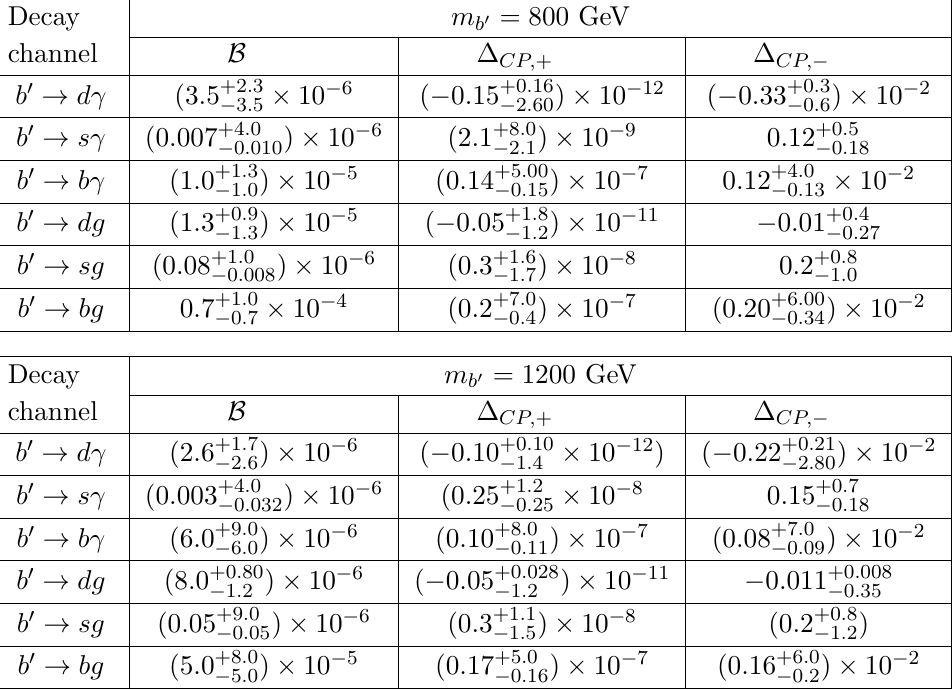
Table 4 . Results for the branching ratios and CP asymmetries for the radiative decay channels of the vector-like quark b 0 . These are based on the best fit mixing parameters and benchmark masses m b 0 = 800 GeV and m b 0 = 1200 GeV outlined in table